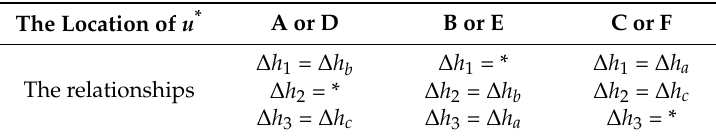
Table 4. The relationship between ∆ h a , ∆ h b , ∆ h c and ∆ h 1 , ∆ h 2 , ∆ h 3